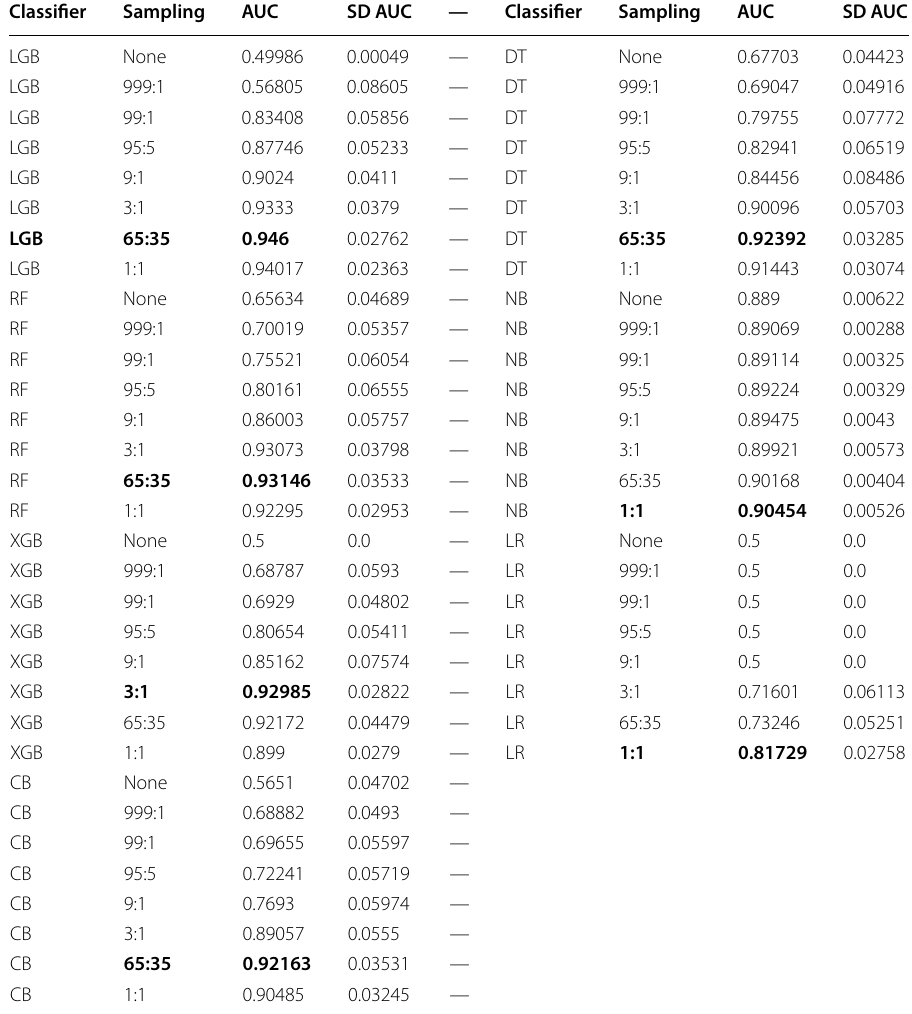
Bolded values indicate highest